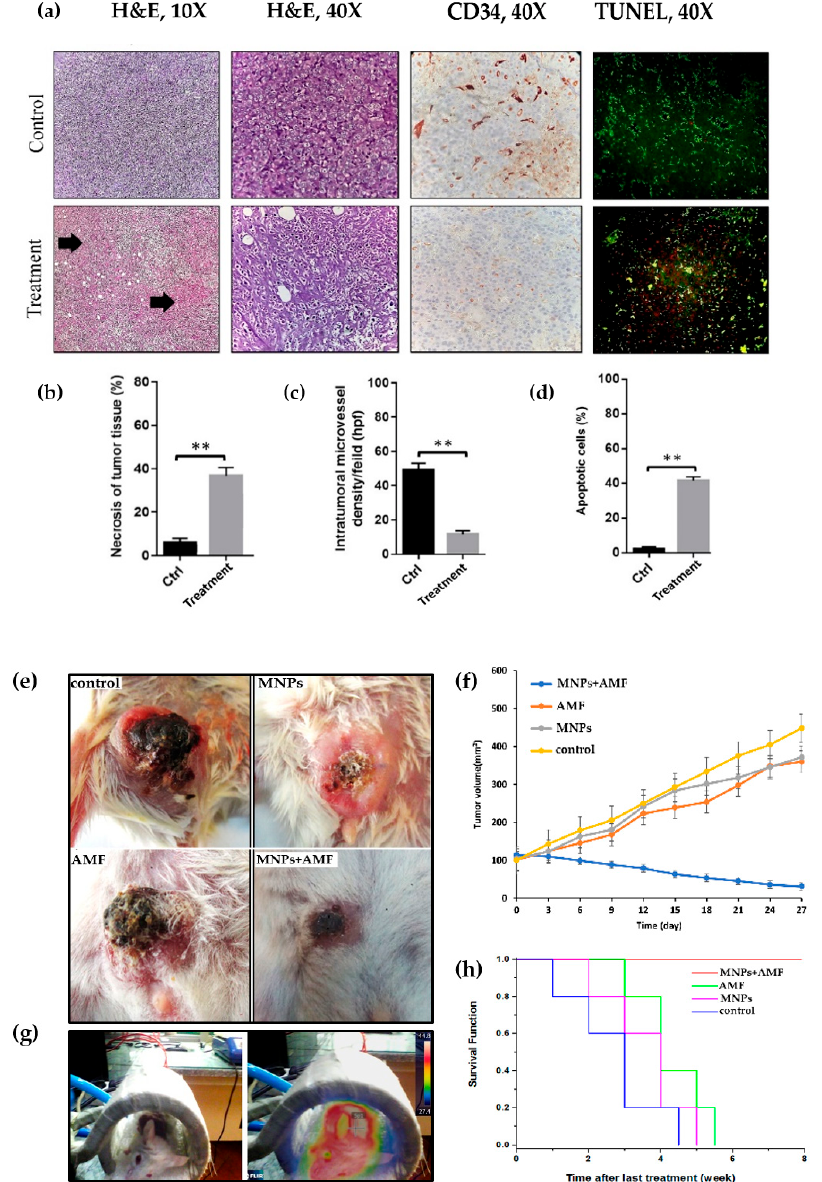
Figure 6. ( a ) Histopathology, immunohistochemistry, and TUNEL assay of breast cancer tissues in control and treated BALB/c mice; ( b ) necrosis of tumor tissue (arrows in histopathological image); ( c ) Immunohistochemical analysis of the cluster of differentiation 34 (CD 34 ) marker was performed to determine the angiogenesis in tumor tissues. The brown color represents positive staining of CD 34 cell marker; ( d ) TUNEL assay was performed to assess the apoptotic cells in the experimental groups. The number of apoptotic-positive cells significantly increased in the treatment group compared to control, red florescent-stained cell nucleus represents apoptotic cells (** p < 0.01); ( e ) tumor shape and appearance in different experimental groups 27 days after the last treatment; ( f ) tumor volume versus time after the last treatment in different groups: magnetic hyperthermia using G 4 @IONPs, only AMF exposure, only G 4 @IONPs injection, and control; ( g ) the tumor temperature was monitored by the forward-looking infrared (FLIR) thermal camera; ( h ) Kaplan-Meier curve showing the survival rate of BALB/c mice over time (8 weeks).